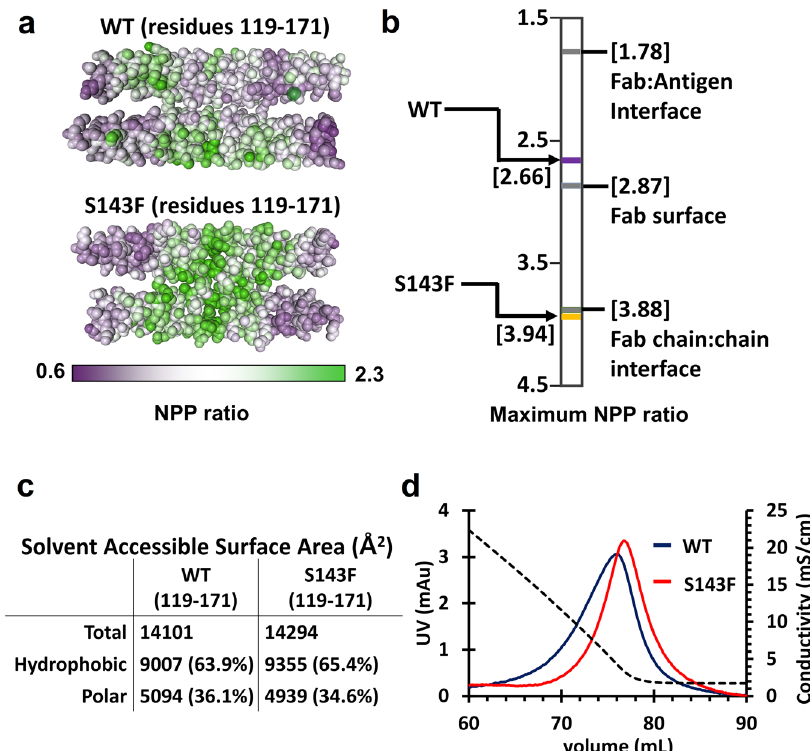
Fig. 5 Calculation of the surface hydrophobicity around the X-shaped contacting region (residues 119 – 171) of the wild-type and S143F mutant lamin A/C. a Residues 119 – 171 were used to calculate the surface hydrophobicities of the wild-type and S143F mutant lamins. The values of the local nonpolar to a polar ratio (NPP) are represented on the surfaces of the lamin proteins, color-coded from low NPP ratio (purple) to high NPP ratio (green). b The maximum NPP values of the X-shaped contacting region on the lamin were calculated using the Protein-Sol server 30 . The standard maximum NPP values are displayed on the bar. The lamin S143F mutant has a higher surface hydrophobicity than the surfaces between the heavy and light chains of antibody Fab (Fab chain:chain interface). c Comparison of the solvent-accessible surface areas in the X-shaped contacting region of the wild-type and S143F mutant lamins. d Pro fi les of hydrophobic interaction chromatography of the wild-type and S143F mutant lamin 300 fragments. The UV curves of wild-type and S143F are represented as blue and red solid lines, respectively. The conductivity curve resulting from the decreasing gradient of the ammonium sulfate concentration is shown as the black dotted